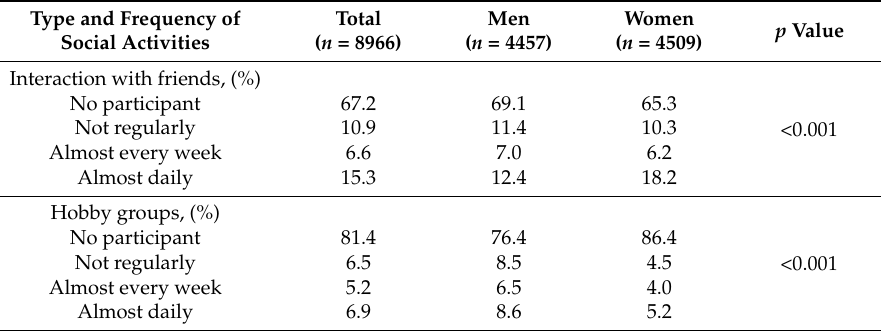
Table 2. Characteristics of type and frequency of social